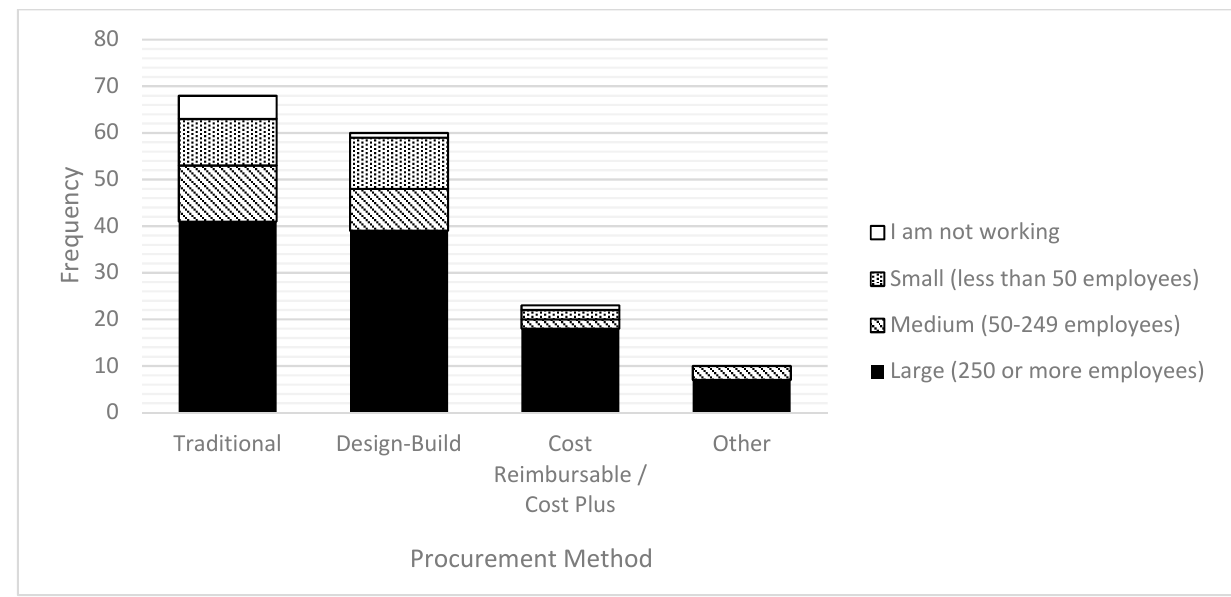
Figure 3. Procurement methods used.